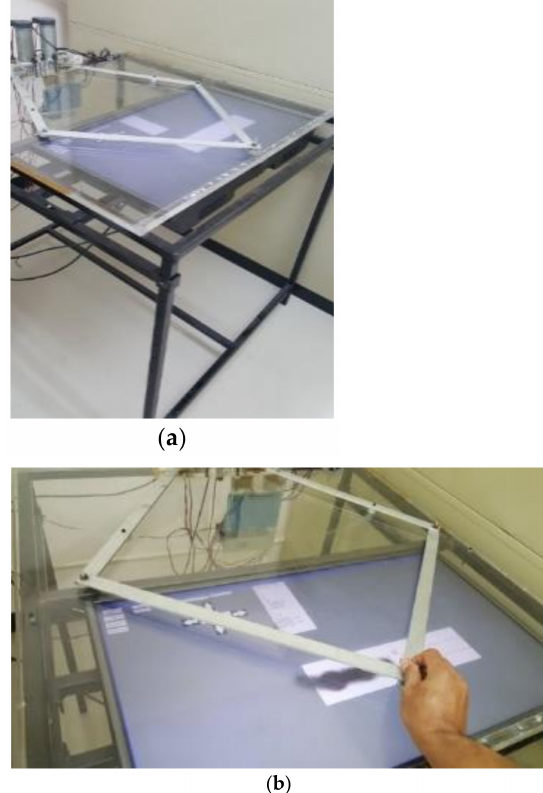
Figure 5. ( a ) A virtual tele-abrasive workstation. ( b ) An example of the blasting